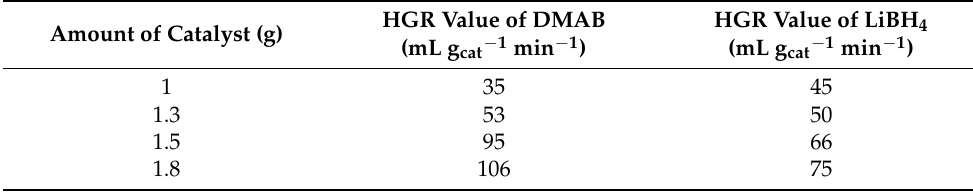
Table 1. H 2 generation rate with nickel catalyst at different catalyst